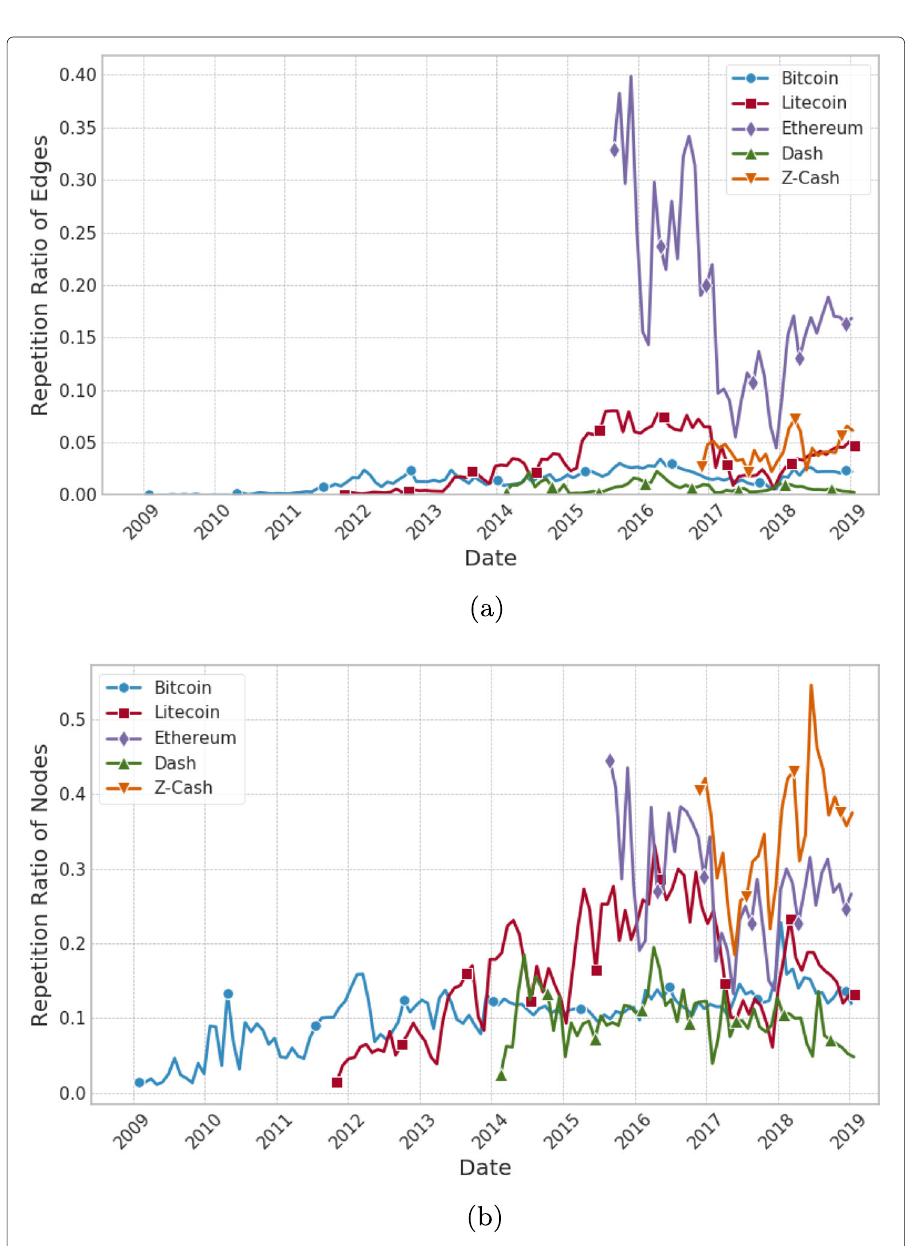
Fig. 10 Repetition ratio of MTG’s nodes and edges over time. a Repetition ratio of edges. b Repetition ratio of